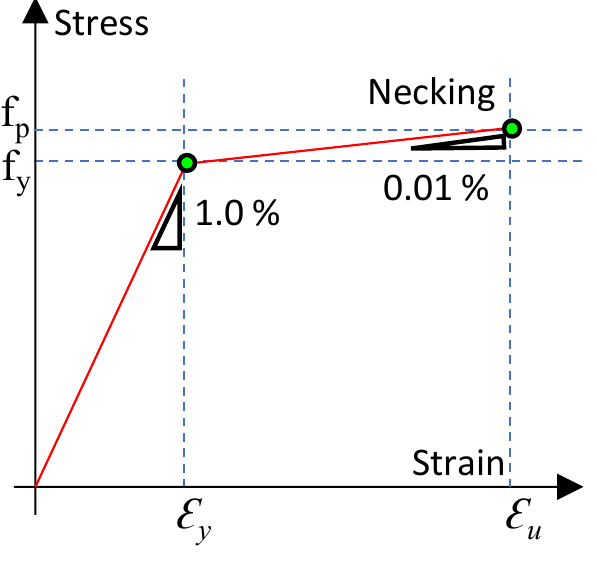
Figure 11. The deck section made of concrete was constantly linear elastic to grasp the nonlinear behavior of the panels and distribute the load evenly to the superstructure.